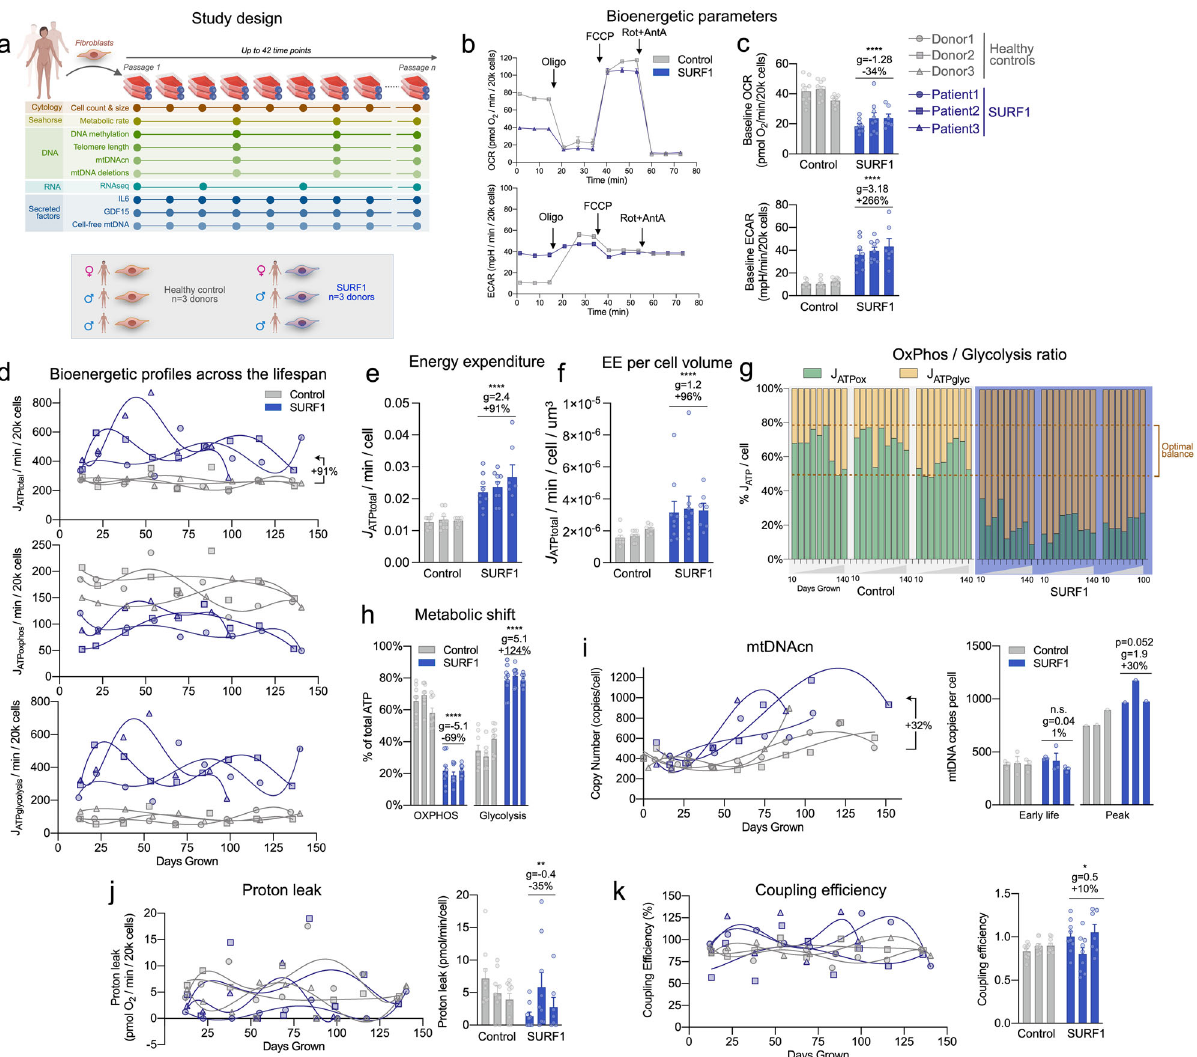
Fig. 2 SURF1 defects decrease metabolic ef fi ciency and cause hypermetabolism without affecting coupling ef fi ciency. a Schematic of the study design with primary human fi broblasts, coupled with repeated, longitudinal measures of cellular, bioenergetic, and molecular pro fi ling across the lifespan. Three Control and three SURF1 donors (one female, two males in each group) were used for all experiments. b Example oxygen consumption rate (OCR) and extracellular acidi fi cation rate (ECAR) obtained from Seahorse measurements of Control and SURF1 cells. c Comparison of average OCR and ECAR values across the cellular lifespan. The speci fi city of the ECAR signal for glycolysis was veri fi ed (see Methods for details). d Lifespan trajectories of ATP production rates ( J ATP ) derived from glycolysis ( J ATP-Glyc ), oxidative phosphorylation ( J ATP-OxPhos ), and total ATP ( J ATP-Total : Glycolytic- + OxPhos-derived rates) over up to 150 days. Percentages show the average difference between SURF1 and Control across the lifespan. e Lifespan average energy expenditure (EE) by cell line and f corrected for cell volume. g Balance of J ATP derived from OxPhos and glycolysis and h quanti fi ed SURF1-induced metabolic shift. Dotted lines in ( h ) denote the range in control cells. i Lifespan trajectory of mtDNAcn and average mtDNAcn at the fi rst 3 time points (early life, days 5 – 40) and peak value across the lifespan. j Lifespan trajectories and averages of proton leak and k coupling ef fi ciency estimated from extracellular fl ux measurements of ATP-coupled and uncoupled respiration. n = 3 individuals per group, 7 – 9 timepoints per individual. Data are means ± SEM. * P < 0.05, ** P <